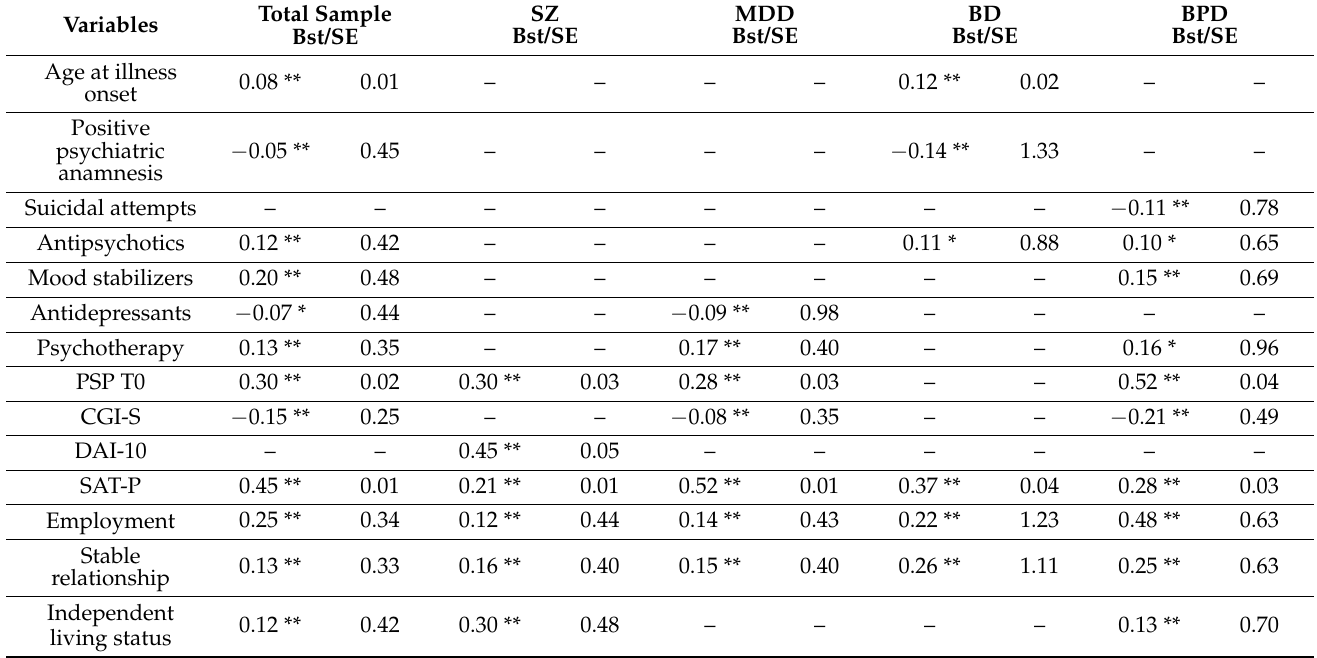
Table 2. Multiple regression analysis in the total group and in the subgroups with a diagnosis of schizophrenia, or major depressive disorder, or bipolar disorder, or borderline personality